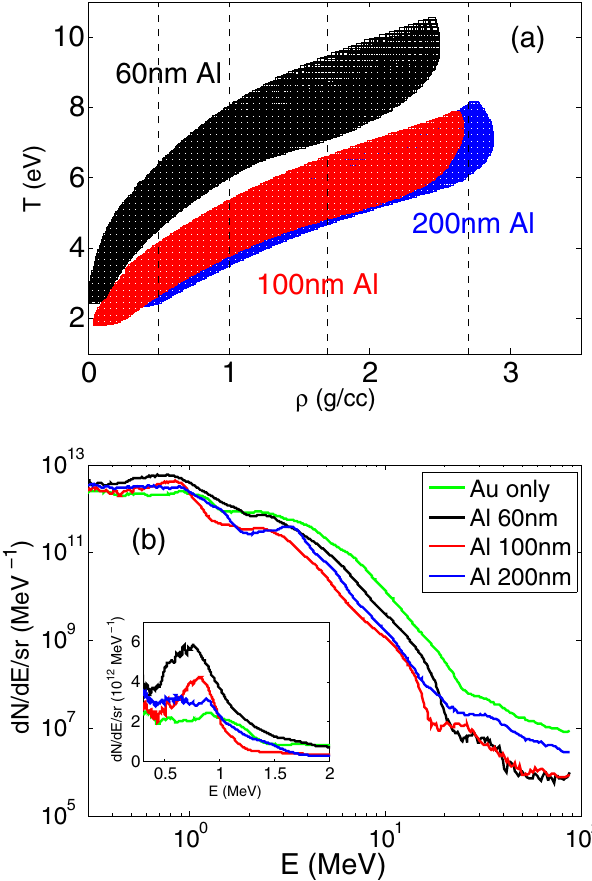
Figure 5. ( a ) Density-temperature range from simulations. ( b ) Proton energy